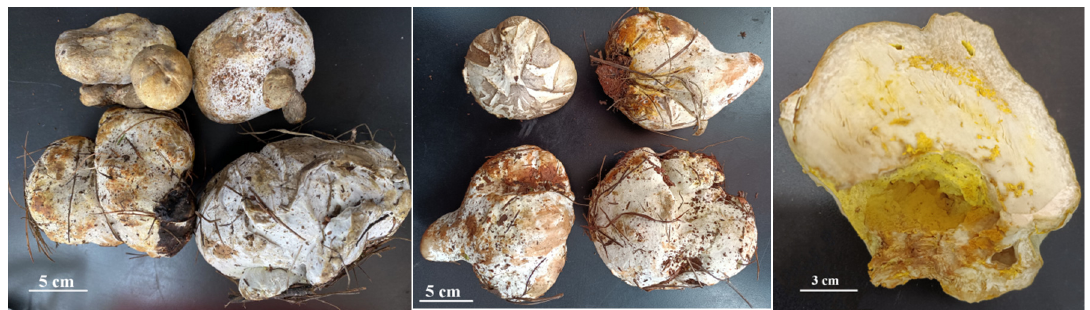
Figure 2. The symbiotic fruiting bodies of B. griseus– mycoparasitic fungus and their vertical sec- tion.